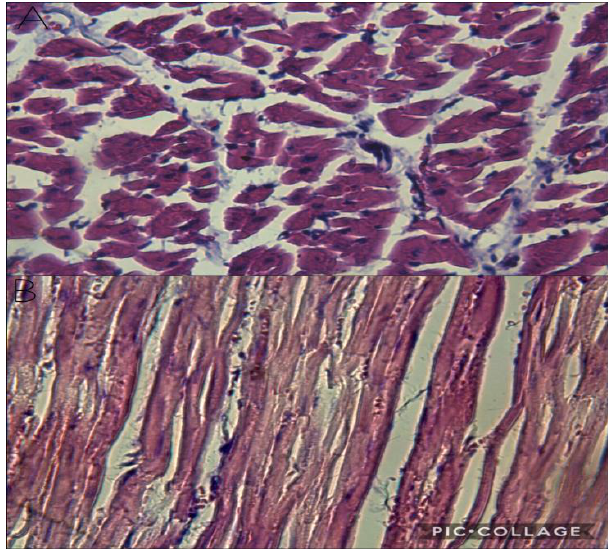
Figure 13. A, subendocardial section showing the subendocardial-layer with transverse running pattern of muscle fibers. B, mesocardial section showing the